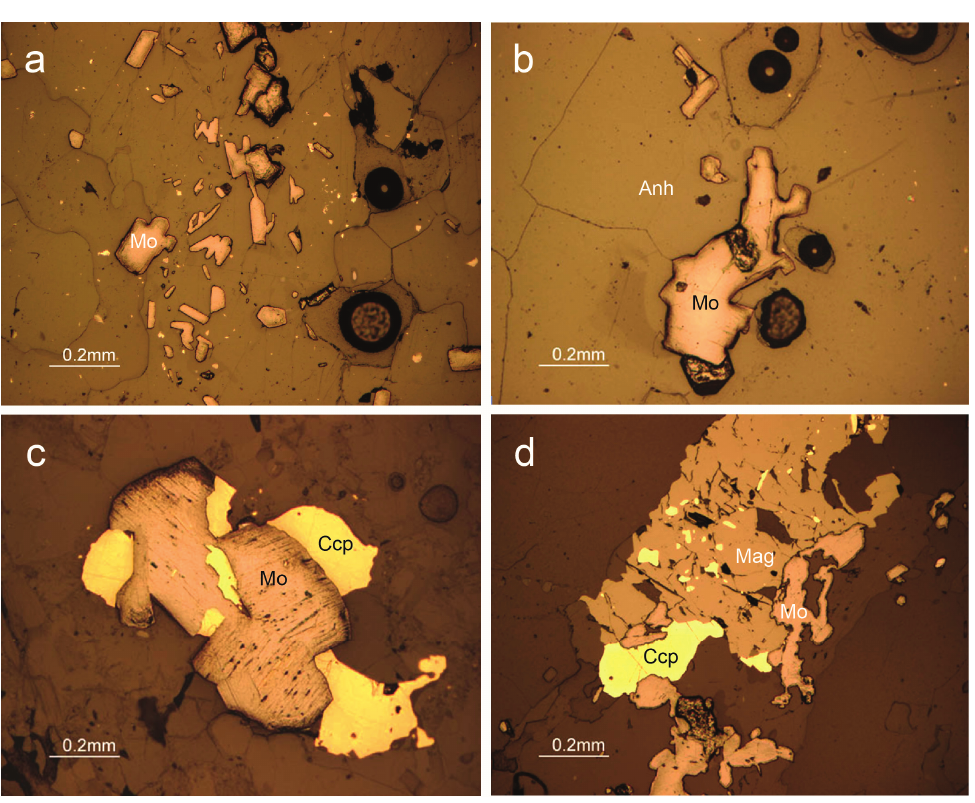
Figure 3. Photomicrographs of characteristic molybdenite in Aitik and Salmijärvi. Reflected light; ( a ) Scattered molybdenite grains in quartz monzodiorite in Aitik (sample Agm751-246.7). Majority of grains are 10–100 μ m; ( b ) Molybdenite aggregate